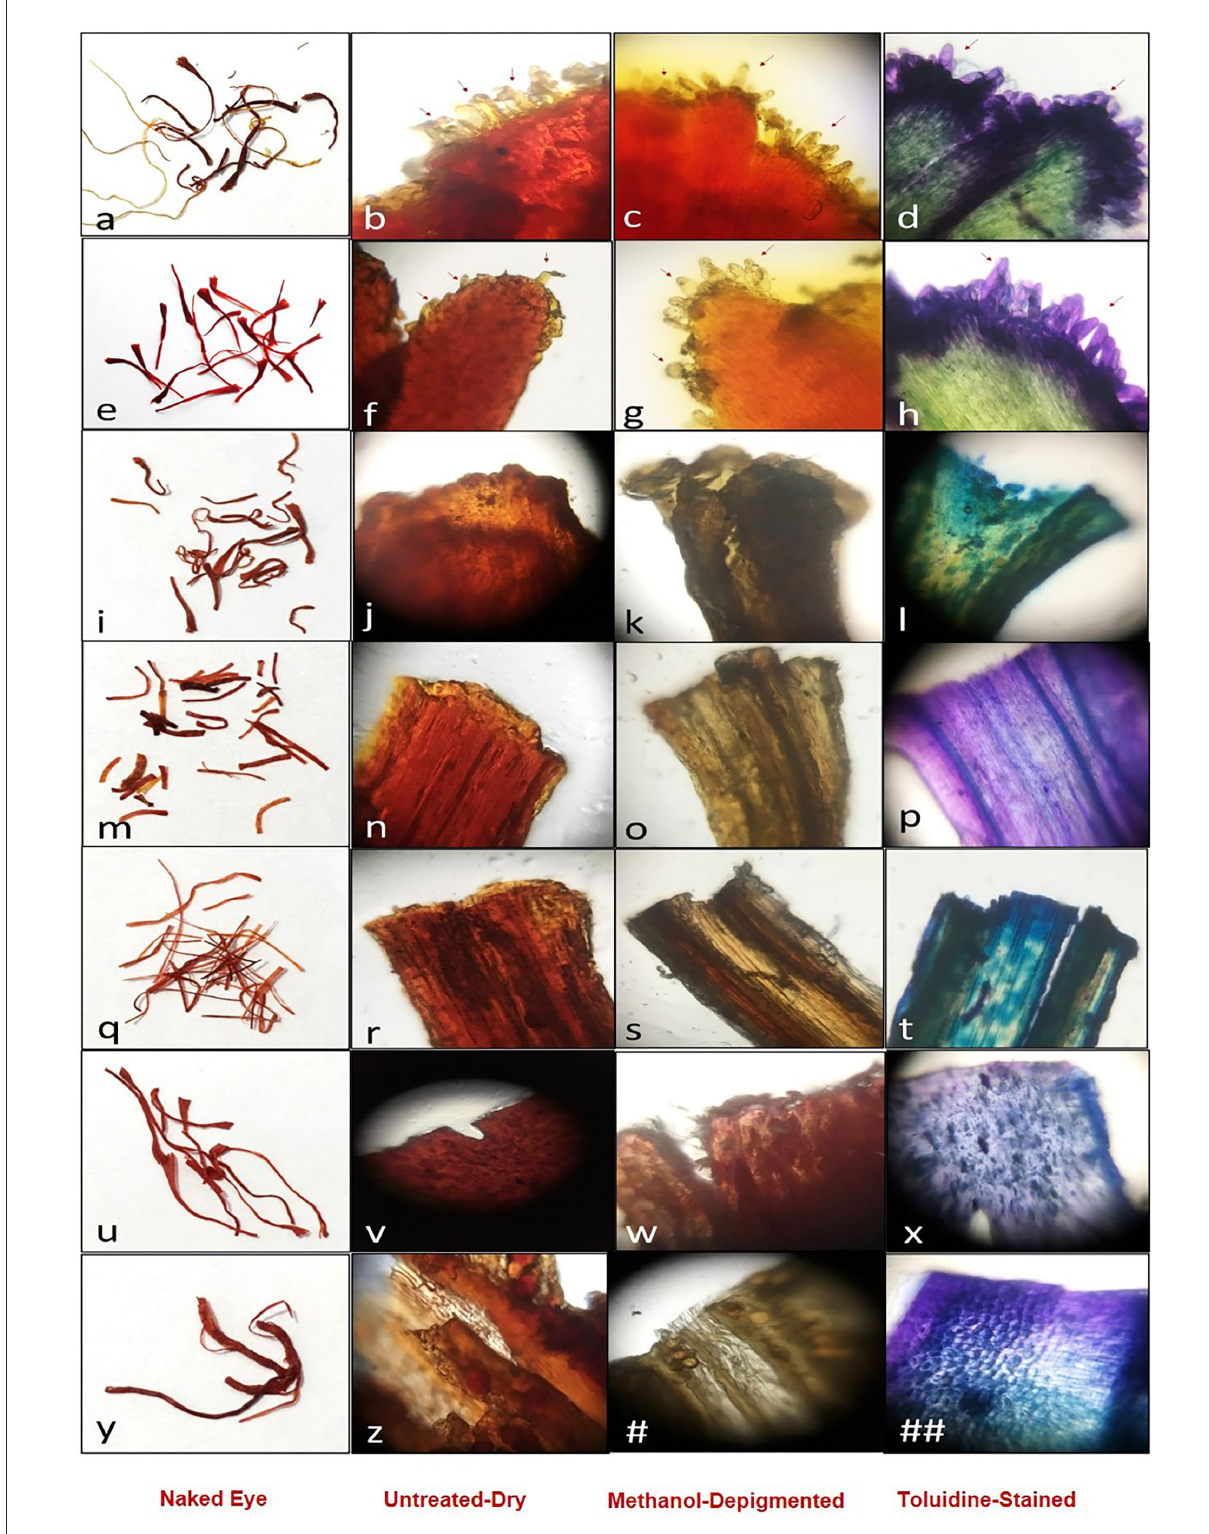
FIGURE2 Poster for the identification of genuine/fake saffron: Genuine saffron (a–d) saffron in filament (Laccha), (e–h) saffron in cut filament (Mongra); fake samples (i–##)